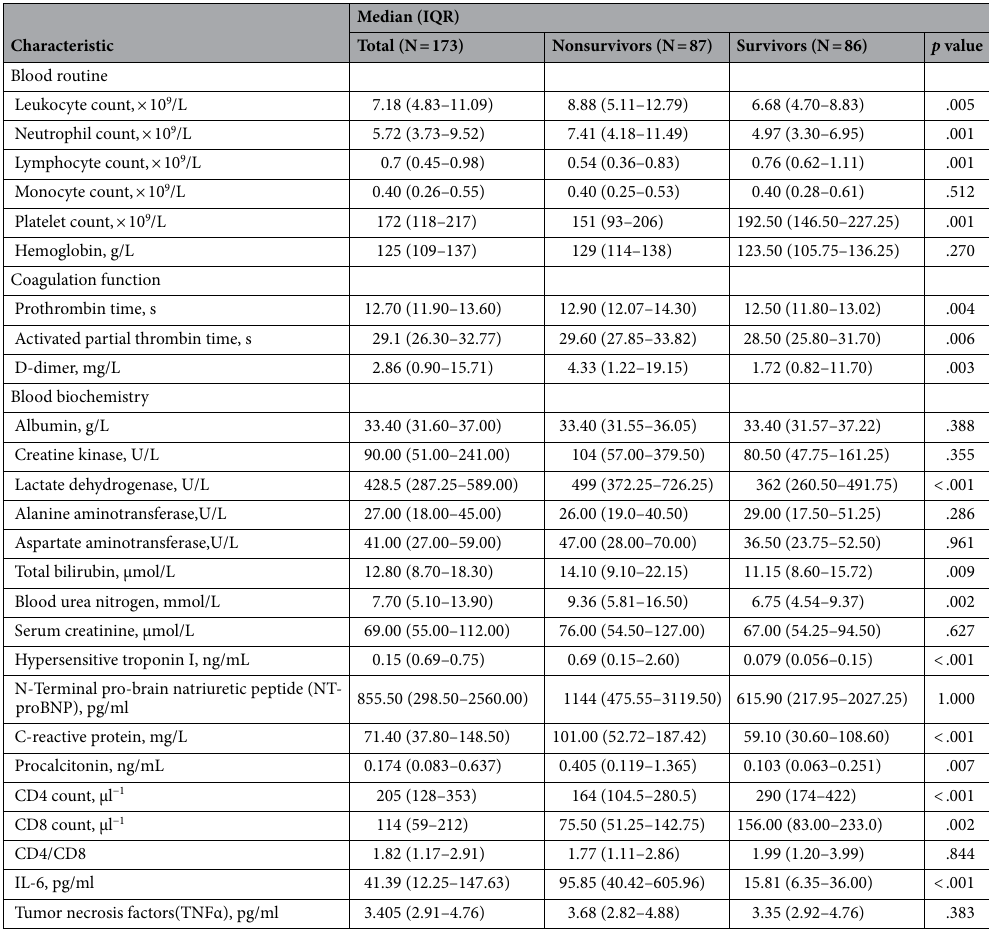
Table 2. Laboratory findings of COVID-19 patients with cardiac injury. SI conversion factors: to convert alanine aminotransferase or aspartate aminotransferase to μkat/L, multiply by 0.0167. IQR, interquartile range; IL-6,